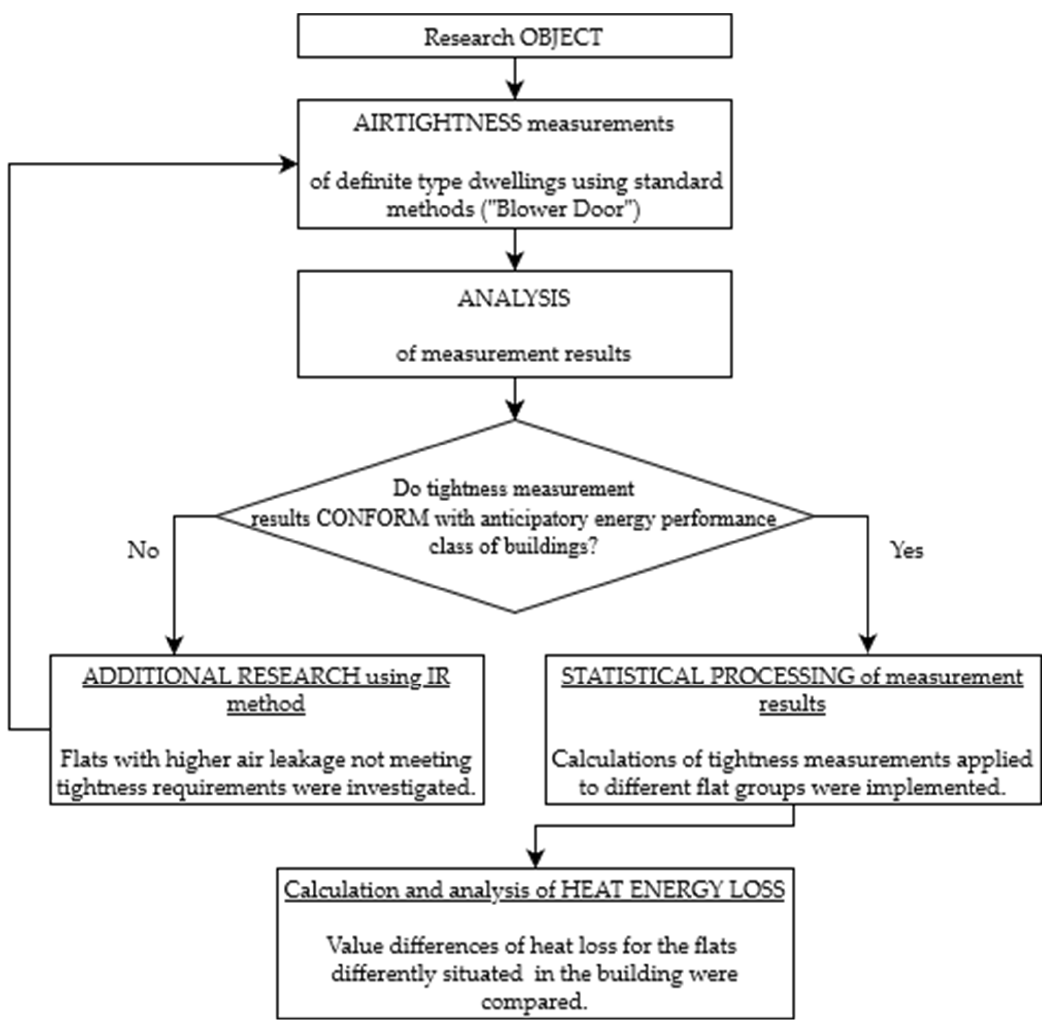
Figure 2. Principal scheme of the research process.